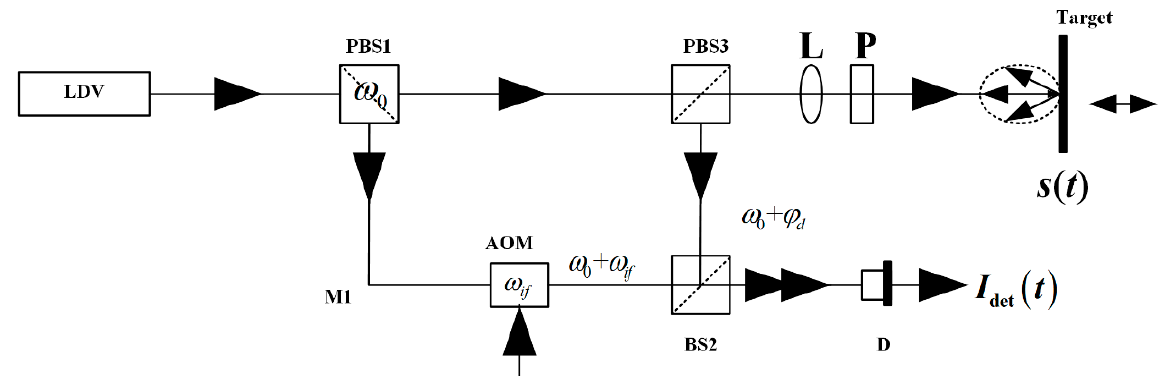
Figure 1. Internal structure of a laser speech measurement system.